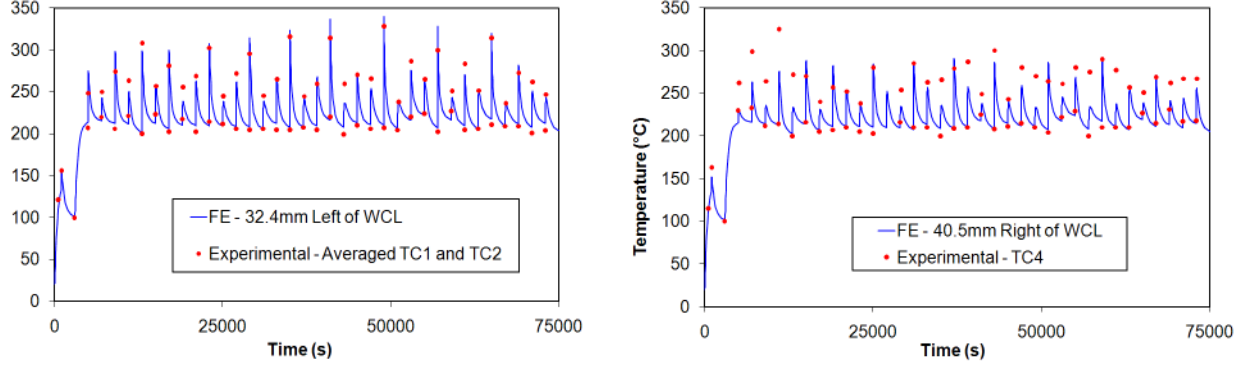
Figure 13. Temperature measurements by TC4 and FE temperature history.